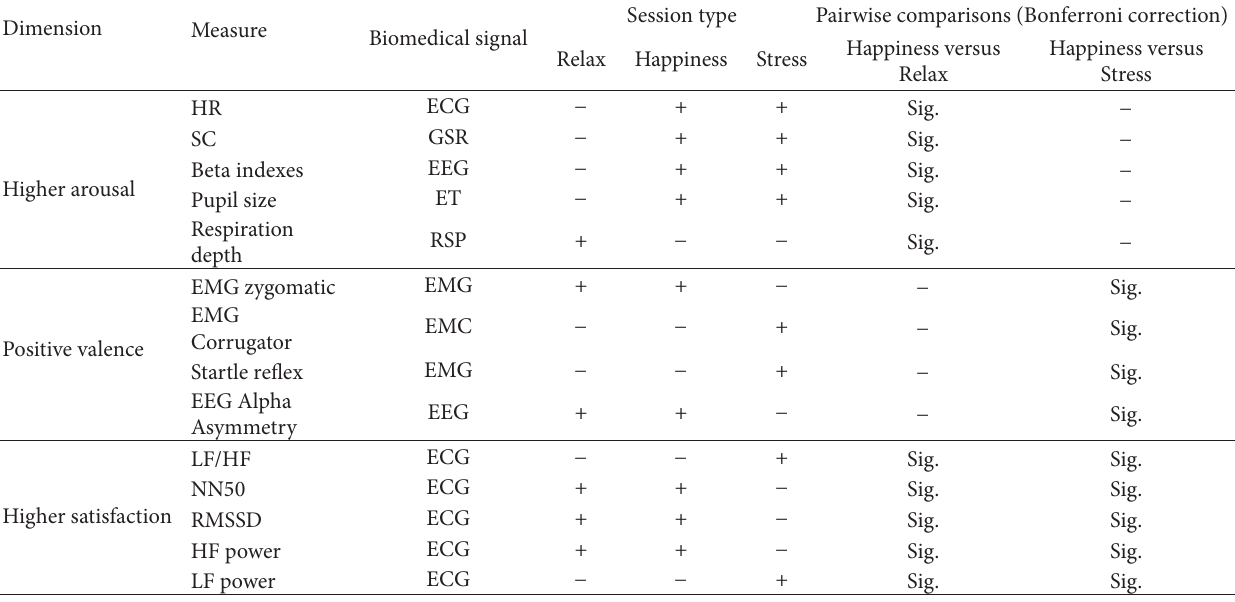
Table 3: Hypotheses per each measure ( − is for lower and + is for